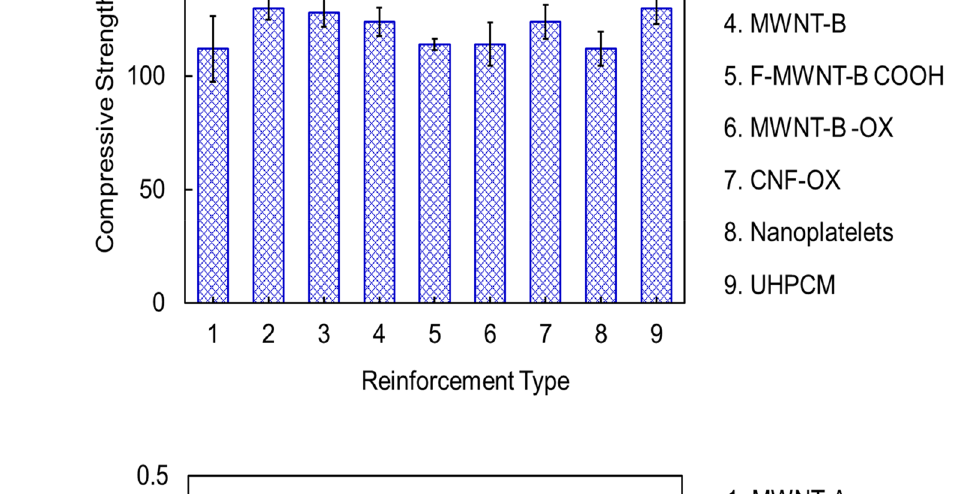
Fig. 8 Abrasion resistance for UHPCM reinforced with carbon-based nanomateri- als at 0.03 wt.%. Error bars shown are standard deviations determined from 6 replicate